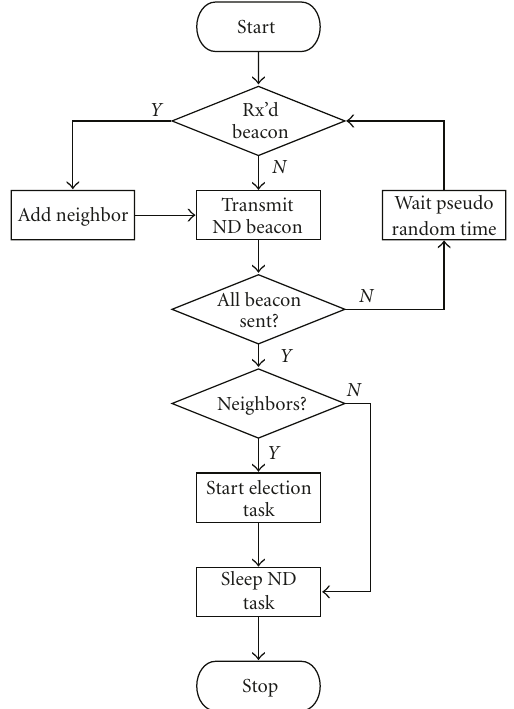
Figure 8: Neighbor discovery protocol. This task initiates wireless communication at a specified interval, synchronized by the GPS time signal. A specified number of beacons are sent at pseudoran- dom intervals to prevent contention for the channel. The beacons do not request